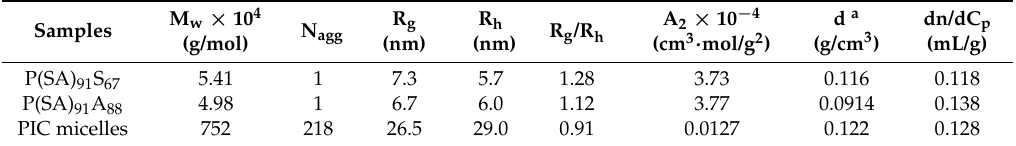
Table 2. Dynamic light scattering (DLS) and static light scattering (SLS) data for P(SA) 91 S 67 , P(SA) 91 A 88 , and PIC micelles in 0.1 M